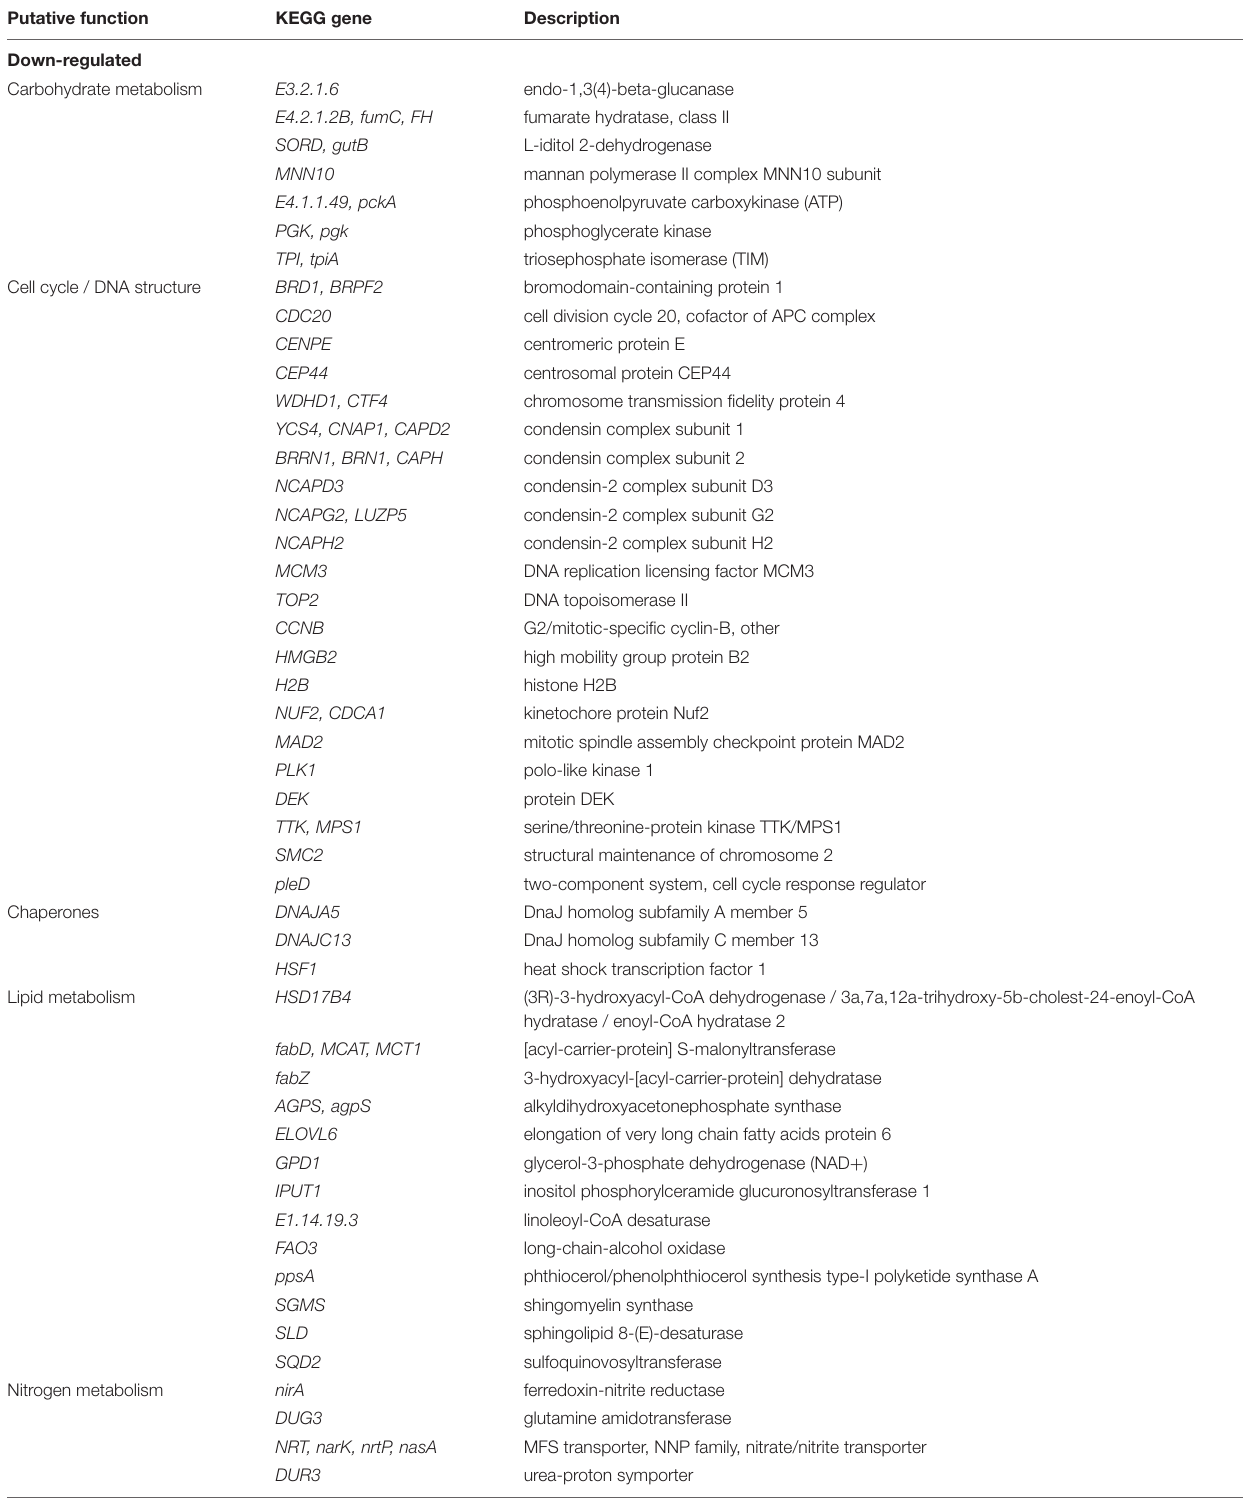
TABLE 4 | Differentially expressed KEGG genes which correspond to functional groups in cellular heat stress responses shared by sporophytes of the Helgoland selfing and both reciprocal crosses among Helgoland and Spitsbergen Laminaria digitata at 20.5 ◦ C in comparison to 10 ◦ C. Putative function KEGG gene